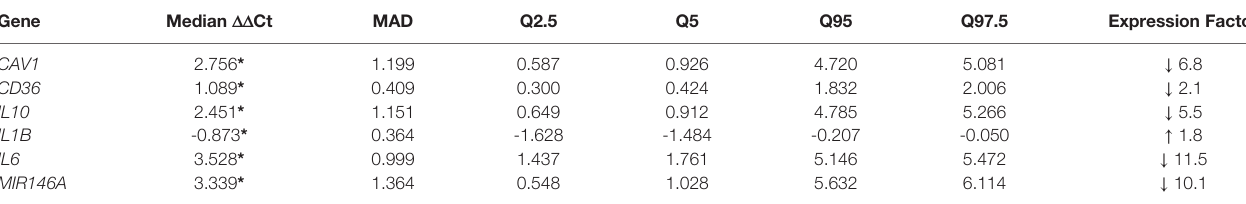
TABLE 4 | Differential gene expression levels between MDSC and AM in BALF, with respect to expression levels in AM.